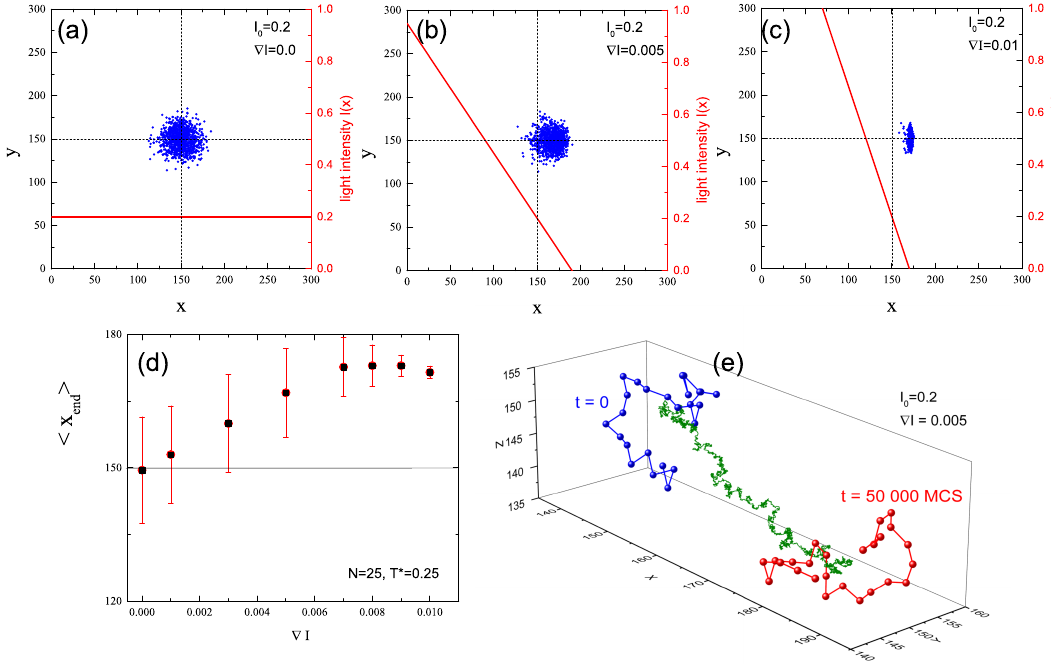
Figure 7. Projection of CM of 10 3 chains onto x − y plane at the end of the simulation for I 0 = 0.2 and ∇ I = 0 ( a ), ∇ I = 0.005 ( b ), and ∇ I = 0.01 ( c ). Red lines are plots of I ( x ) , Equation (3) (right axis). Plot of averaged position < x end > of CM and its standard deviation ( d ). Exemplary initial ( t = 0, blue circles) and final ( t = 5 × 10 4 MCS, red circles) configurations of the chain and trajectory of CM during illumination phase (green points) for I 0 = 0.2 and ∇ I = 0.005 ( e